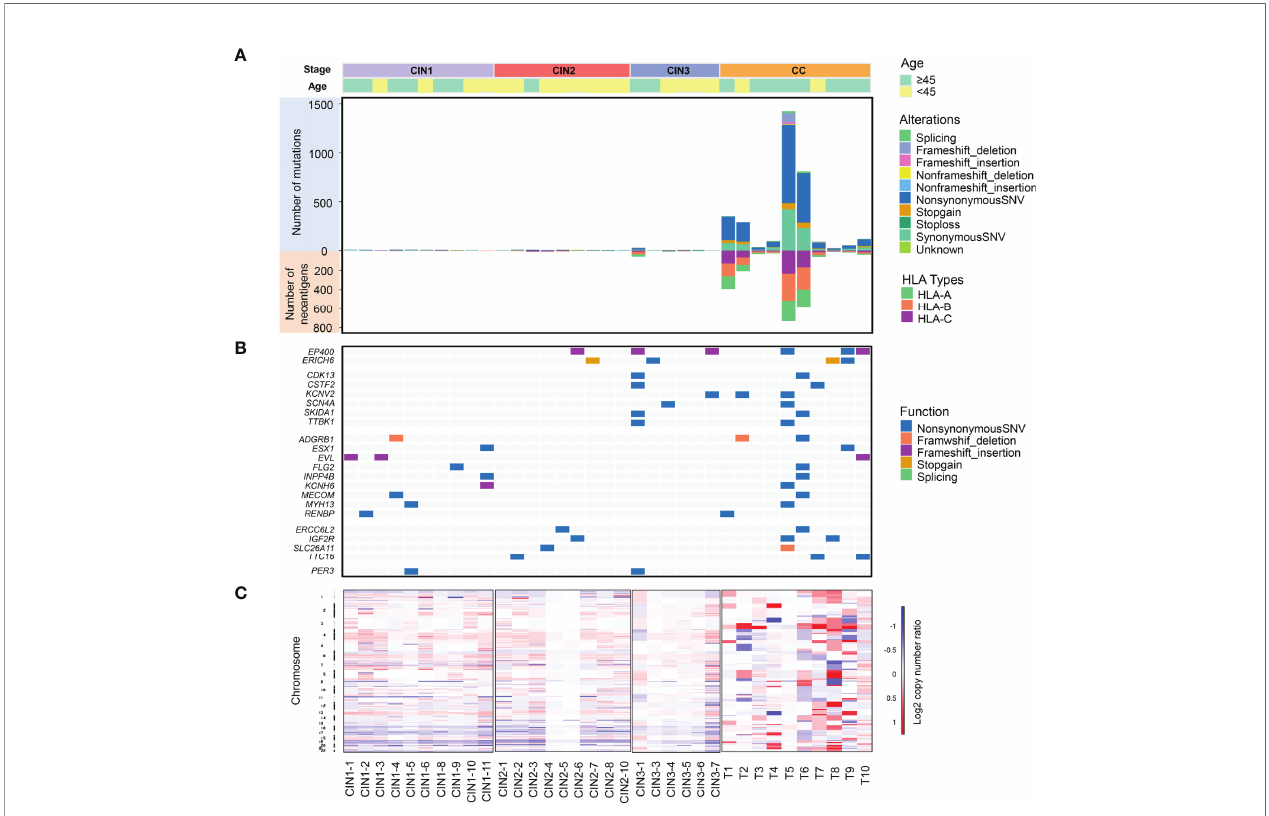
FIGURE 2 | A comprehensive mutational feature of 35 cervical neoplasia genomes by whole-exome sequencing. (A) Upper panel: The number of all the mutations in genomes was depicted. Each bar represented an individual cervical neoplasia sample. Different colors represented different mutation types. The number of somatic mutations in CCs were signi fi cantly higher than in CINs (t-test, p = 6.60E-04). Lower panel: Predicted HLA class I neoantigens in 35 cervical neoplasia samples. Different colors represented different HLA types. The number of exome-derived neoantigens in CCs were signi fi cantly higher than in CINs (t-test, p = 3.62E- 04). (B) A heatmap showed the genes were both detected in CINs and CCs. (C) DNA copy number segments of 35 cervical neoplasia patients showed that CNAs events were detected more frequently in CCs than in CINs. Red and blue boxes represented copy number ampli fi cation and deletion events, respectively (x-axis, 35 cervical neoplasia patients in each group; y-axis, chromosome